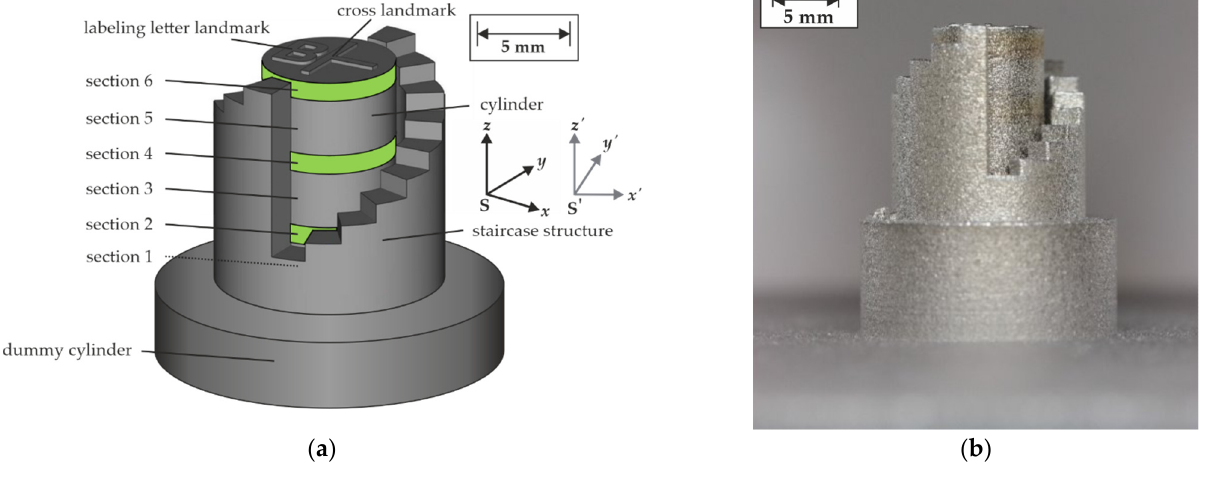
Figure 1. ( a ) Specimen design including staircase structure, top surface cross landmark, labeling letter landmark, dummy cylinder, and the introduced coordinate systems S and S ’. The green areas mark sections that were manufactured using increased VED. In this view, section 1 is hidden behind the staircase which is indicated by the dashed line. ( b ) Manufactured specimen on dummy cylinder. Adapted from Ref. [28]. Table 1. Overview of the manufacturing conditions of the different cylinder sections (corresponding to specimen “B” in [28]). In the last column, the relative increase of the VED in comparison to sections 1, 3, and 5 is given by the percentage value in